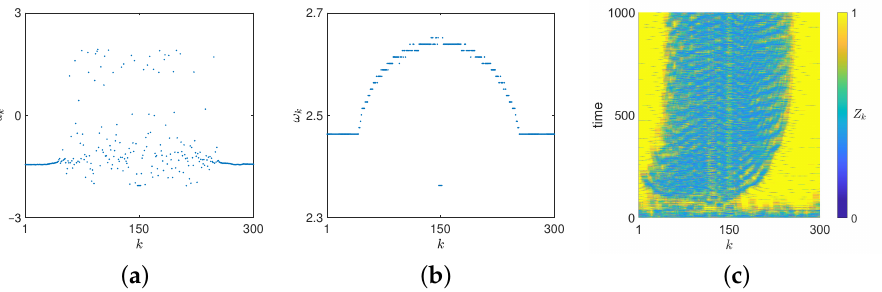
Figure 2. Effect of synaptic pruning on a FHN system. Neurons 148–152 are pruned. The coherent domain is repelled by the pruned region. ( a ) Snapshot of the variables u k for t = 1000, ( b ) mean phase velocities ω k , ( c ) local order parameter Z K . Parameters: N = 300, r = 0.35, σ = 0.1, σ P = 0.2, a = 0.5, φ = π /2 − 0.1.